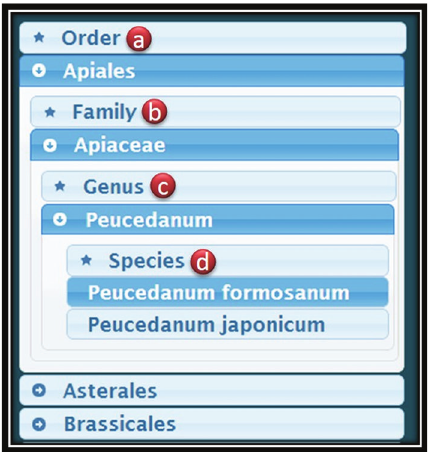
Figure 2: The taxonomy toolbar of browse tool. Users can browse plants by sequentially select (a) order, (b) family, (c) genus, and (d) species. Figure 3: The search tools. Five search tools are available, including (a) the part of the plants, (b) the class of the chemicals, (c) botanical name, and (d) chemical